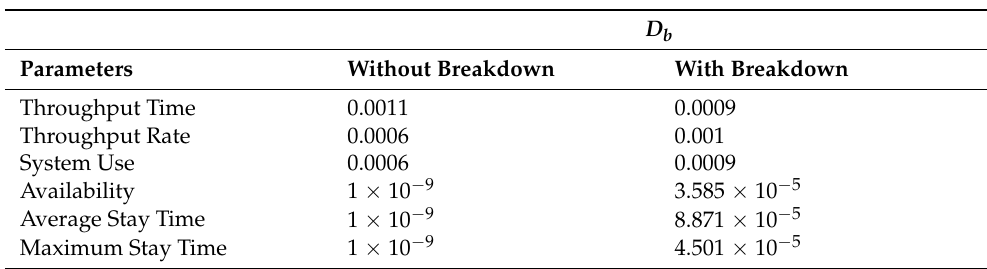
Table 10. Degree of divergence values.